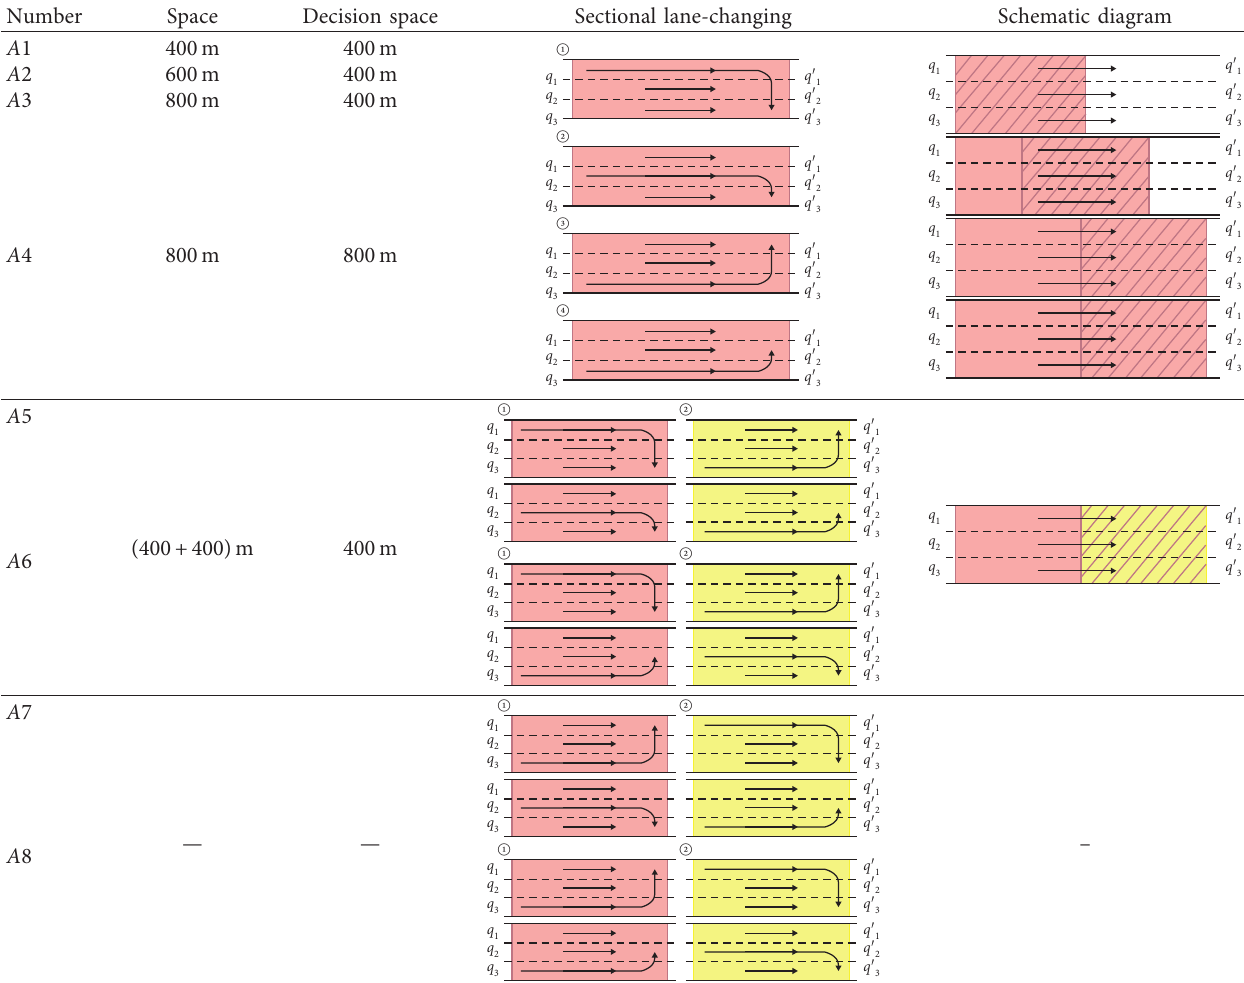
Table 2: Schematic diagrams of the lane-changing simulation plans.